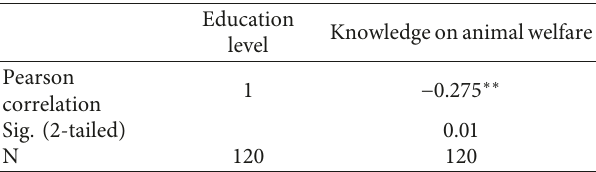
Table 3: Correlation between level of education and farmers’ knowledge on broiler welfare.